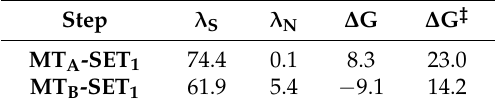
Table 1. Marcus theory calculated values for the two models for the first SET step. Energies in kcal/mol.